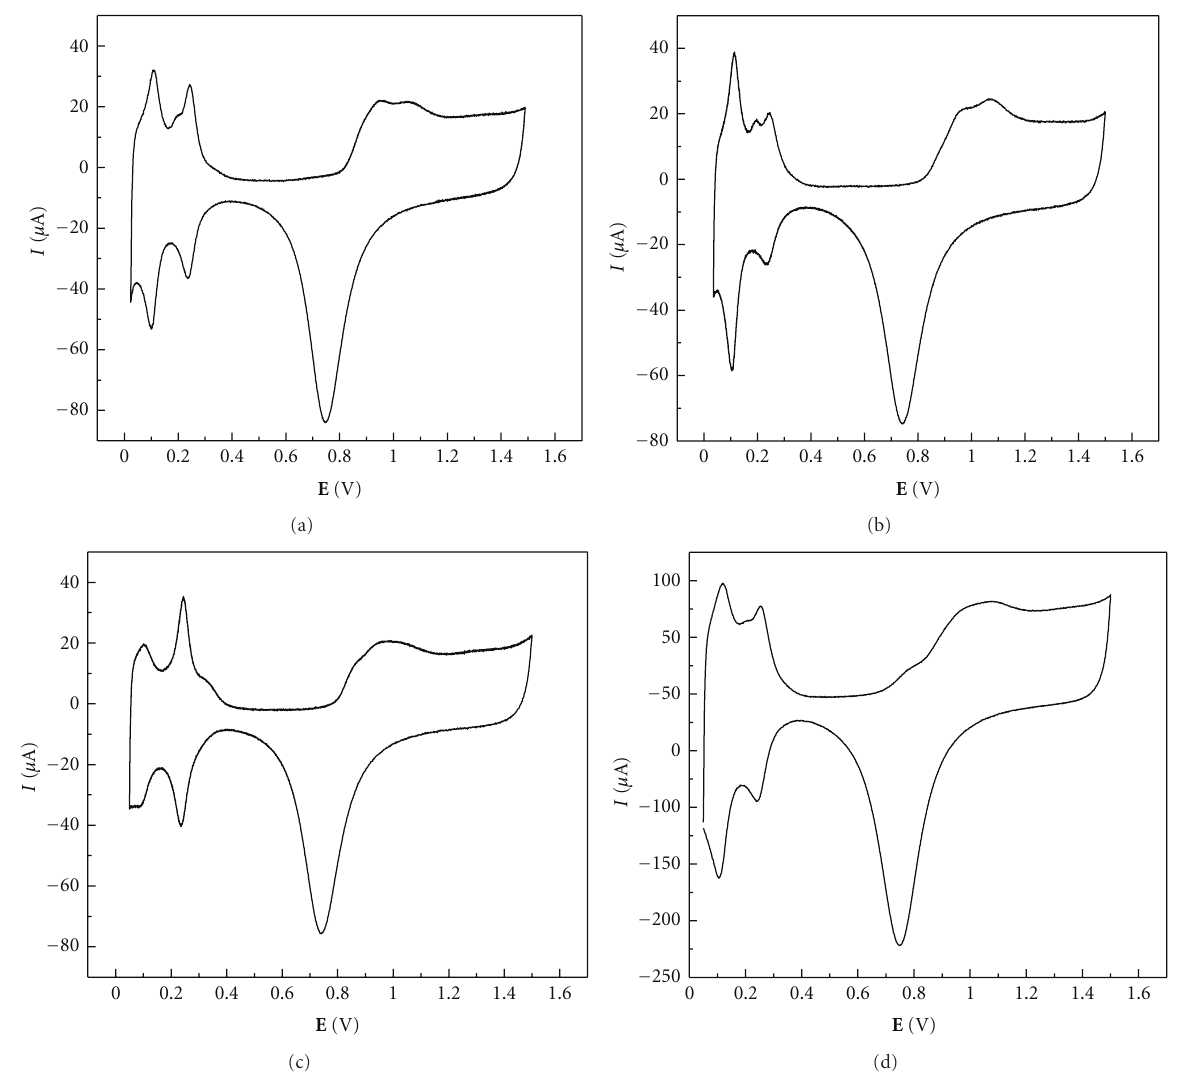
Figure 1: Cyclic voltammetry in 1M sulphuric acid between 0.05 V and 1.50 V run at 0.10 Vs − 1 for (a) Pt pc annealing h 2 /h 1 = 0 . 84; (b) Pt F(111) after a RSWPS E d = 0 . 70V, E u = 1 . 40 V, f = 2 . 5 kHz, t = 10 minutes, h 2 /h 1 = 0 . 52; (c) Pt F(100) after an RSWPS E d = 0 . 00 V, E u = 1 . 50V, f = 5 . 0kHz, t = 10 minutes, h 2 /h 1 = 1 . 80; (d) CT Pt after E = − 2V, t = 30 minutes. h 2 /h 1 = 0 .